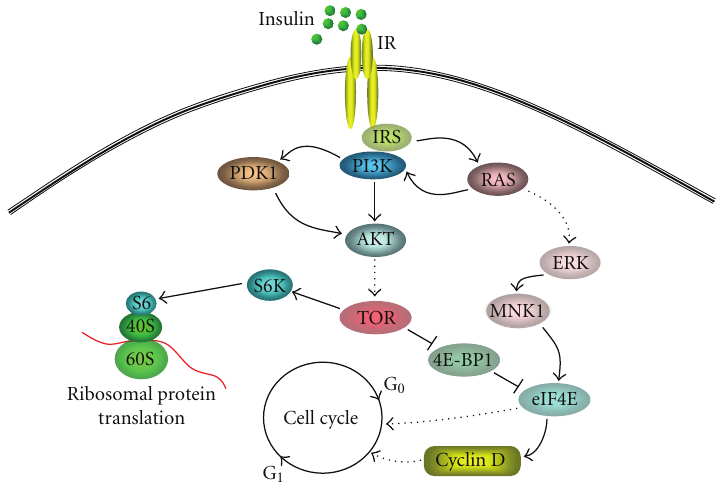
Figure 1: Upon binding of insulin, the IR undergoes autophosphorylation which enables the receptor to have a kinase activity and phosphorylates various cytoplasmic substrates, such as IRSs. From this point, signaling proceeds via a variety of signaling pathways (i.e., PI3K signaling pathway, Ras and MAP kinase cascade) that are responsible for the metabolic, growth-promoting and mitogenic e ff ects of insulin.